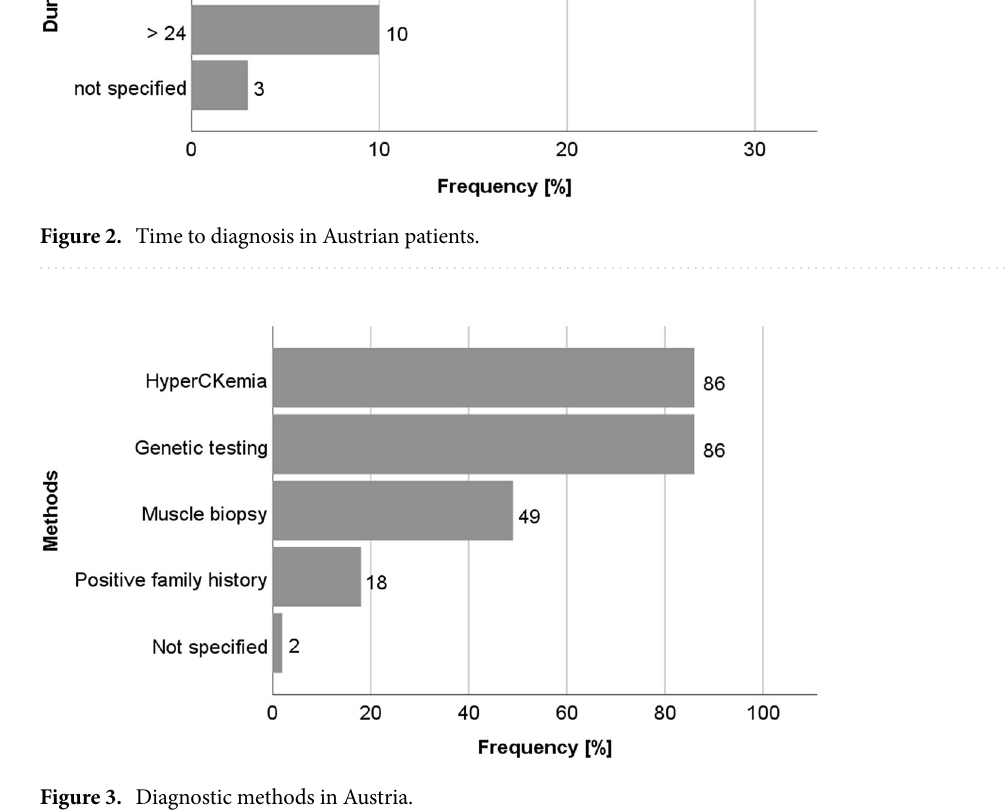
Figure 3. Diagnostic methods in